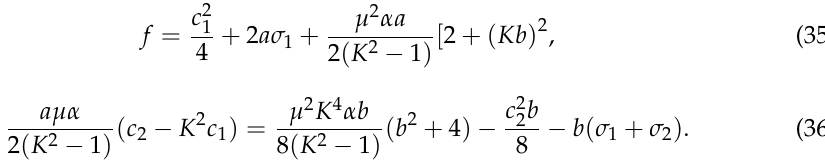
Figure 2. Time history portraits of  and  when ( a , c ) during the time interval [ 0,100 ] s and ( b , d ) during the time interval [ 0,200 ] s